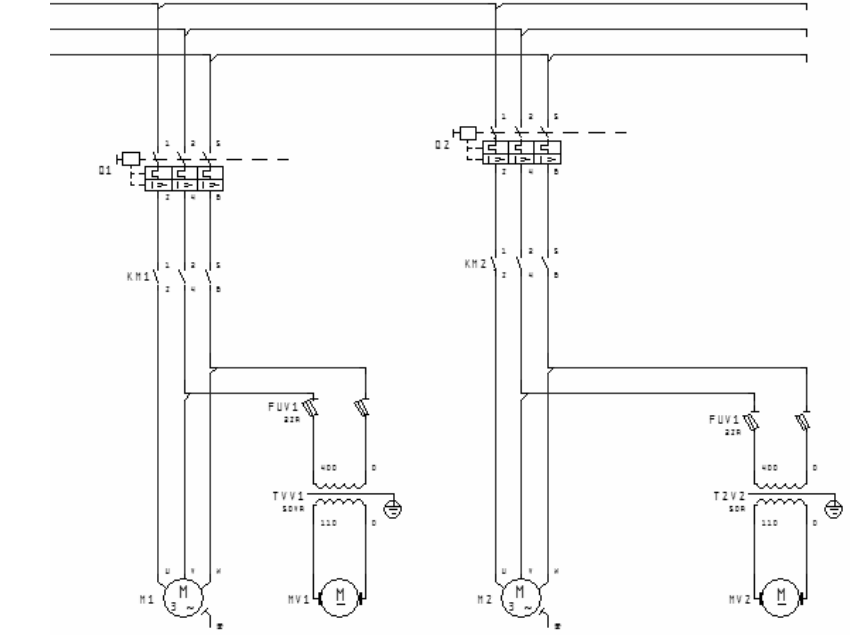
Figure 1 – Scheme of the motor and the motor control of the air compressor and the relevant fans – current